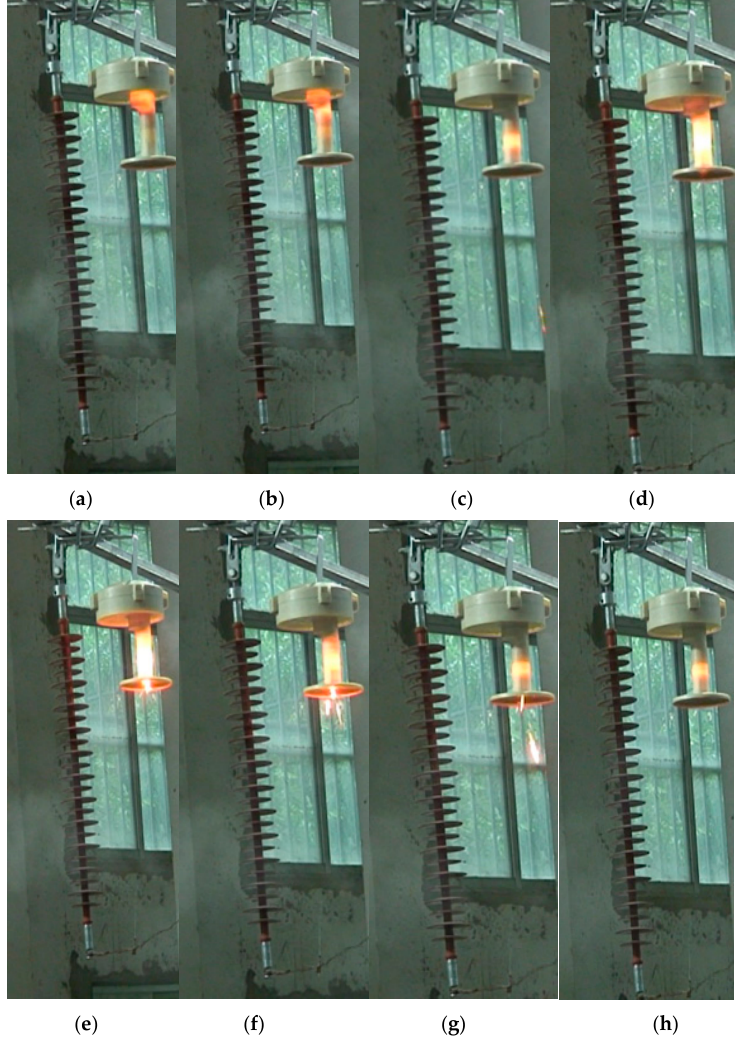
Figure 9. Action snapshot of the device. ( a ) Action snapshot at t = 12 µ s, ( b ) Action snapshot at t = 17 µ s, ( c ) Action snapshot at t = 22 µ s, ( d ) Action snapshot at t = 27 µ s, ( e ) Action snapshot at t = 32 µ s, ( f ) Action snapshot at t = 37 µ s, ( g ) Action snapshot at t = 42 µ s, ( h ) Action snapshot at t = 50 µ s.